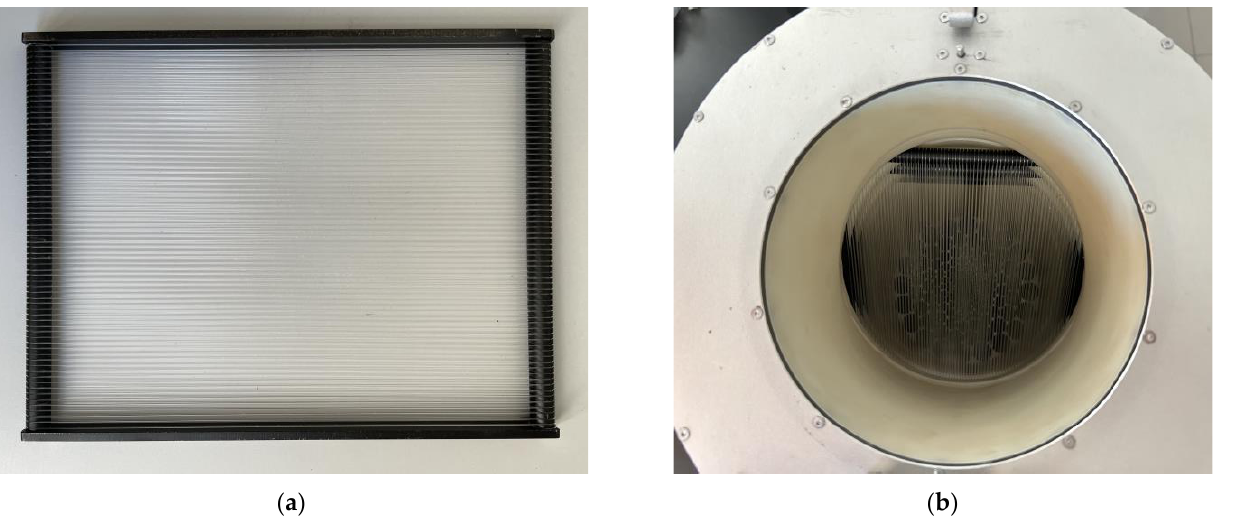
Figure 3. The frame that wraps around the collecting strands ( a ) and the position of frames in the sampler ( b ).